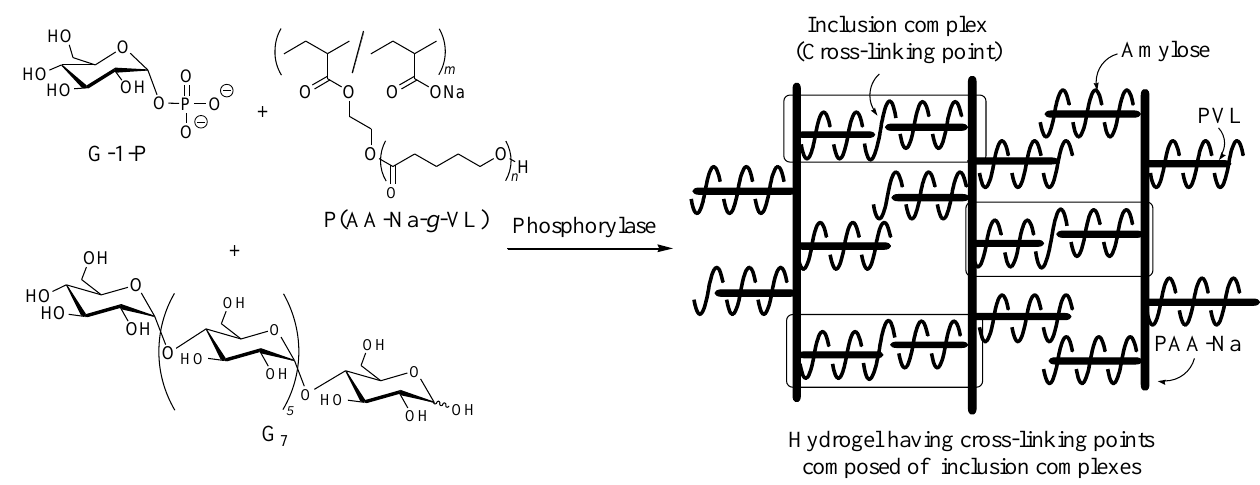
Figure 11. Preparation of Hydrogels through Formation of Inclusion Complexes of Amylose by Vine-Twining Polymerization.